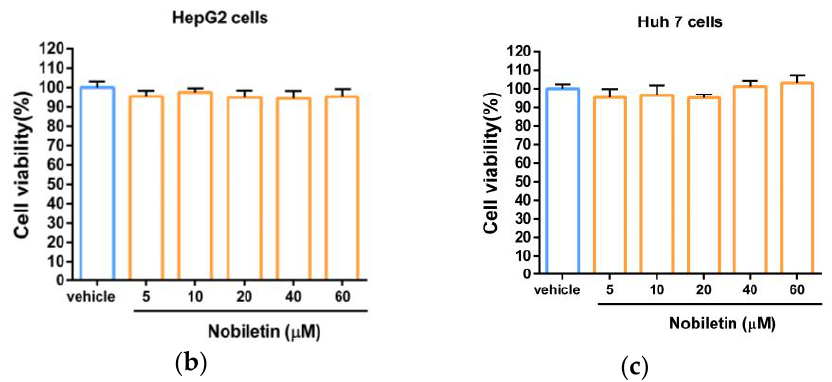
Figure 1. Effects of nobiletin on the viability of hepatic cells. ( a ) The chemical structure of nobiletin (5,6,7,8,3 ′ ,4 ′ -hexamethoxyflavone). ( b ) HepG2 and ( c ) Huh 7 cells were treated with vehicle (0.1% DMSO) or nobiletin (5, 10, 20, 40 and 60 μM) for 24 h. Cell viability was analyzed with MTT assays. The data are shown as the mean ± SD of three independent experiments.